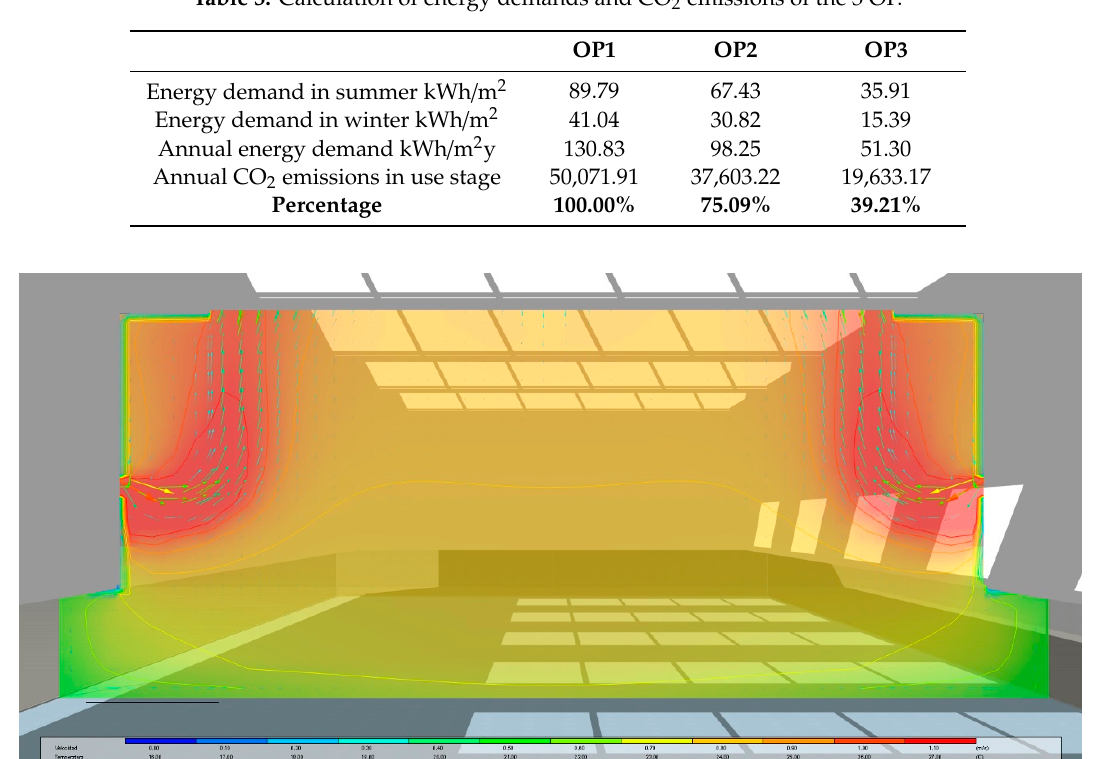
Table 3. Calculation of energy demands and CO 2 emissions of the 3 OP.